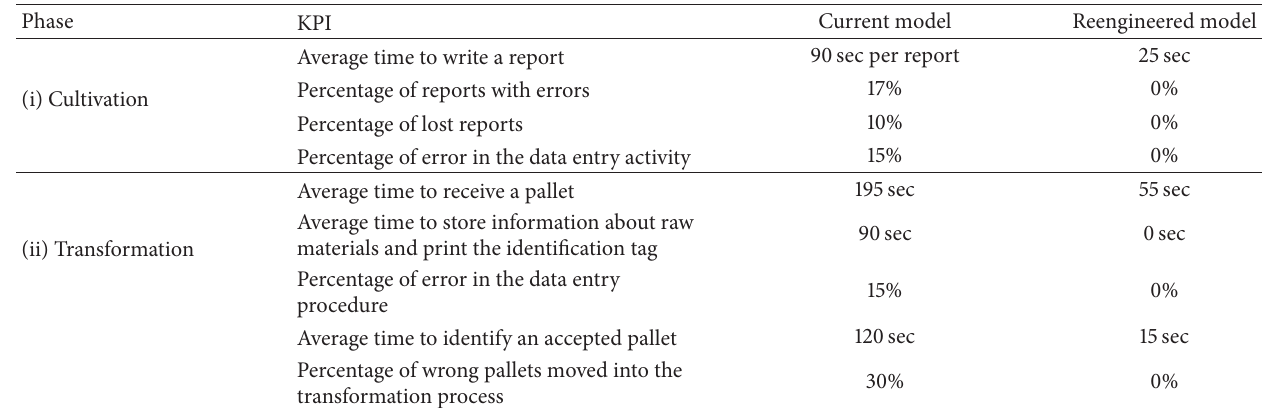
Figure 10: The ePedigree for a specific product. Table 3: Main KPI used to compare current and re-engineered